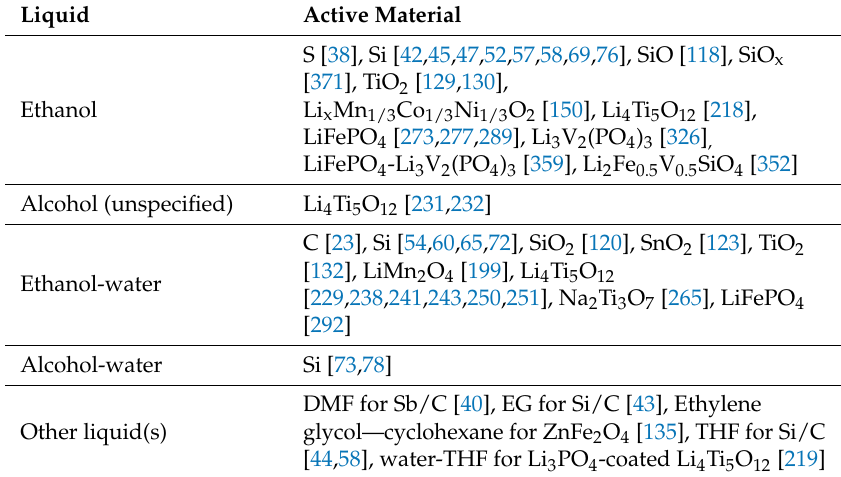
Table 2. Spray-drying synthesis of active materials involving organic or partially organic suspensions.